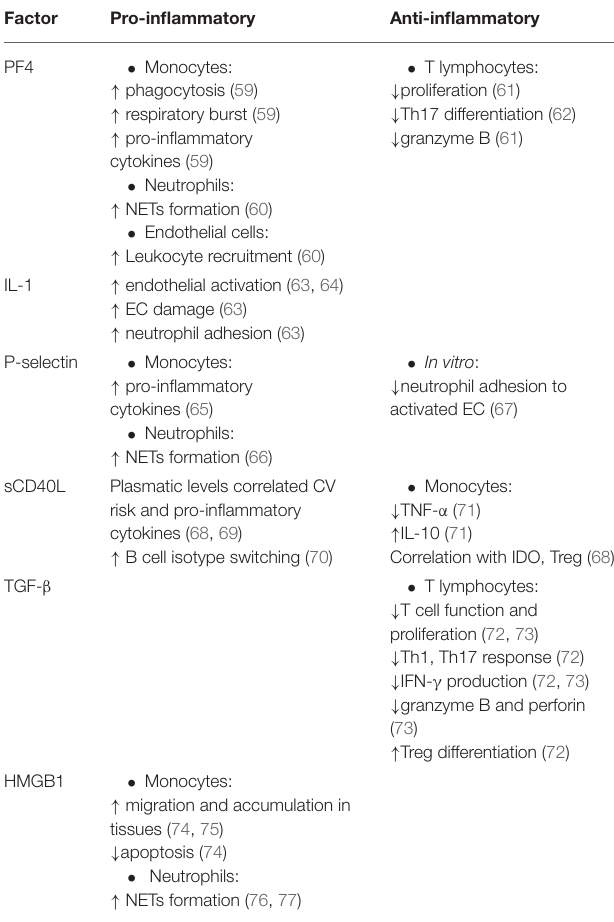
TABLE 1 | Evidences of dual role of expressed/secreted platelet factors.